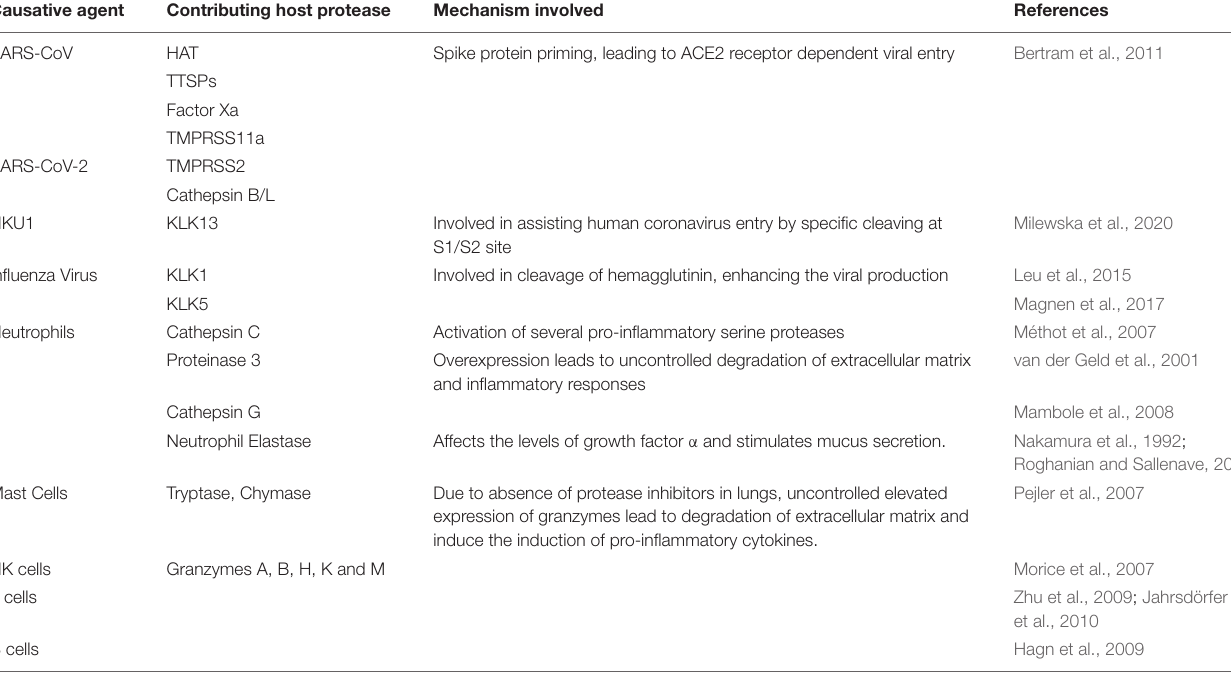
TABLE 1 | Summarizing potential host proteases contributing to viral entry and uncontrolled immune response against viral